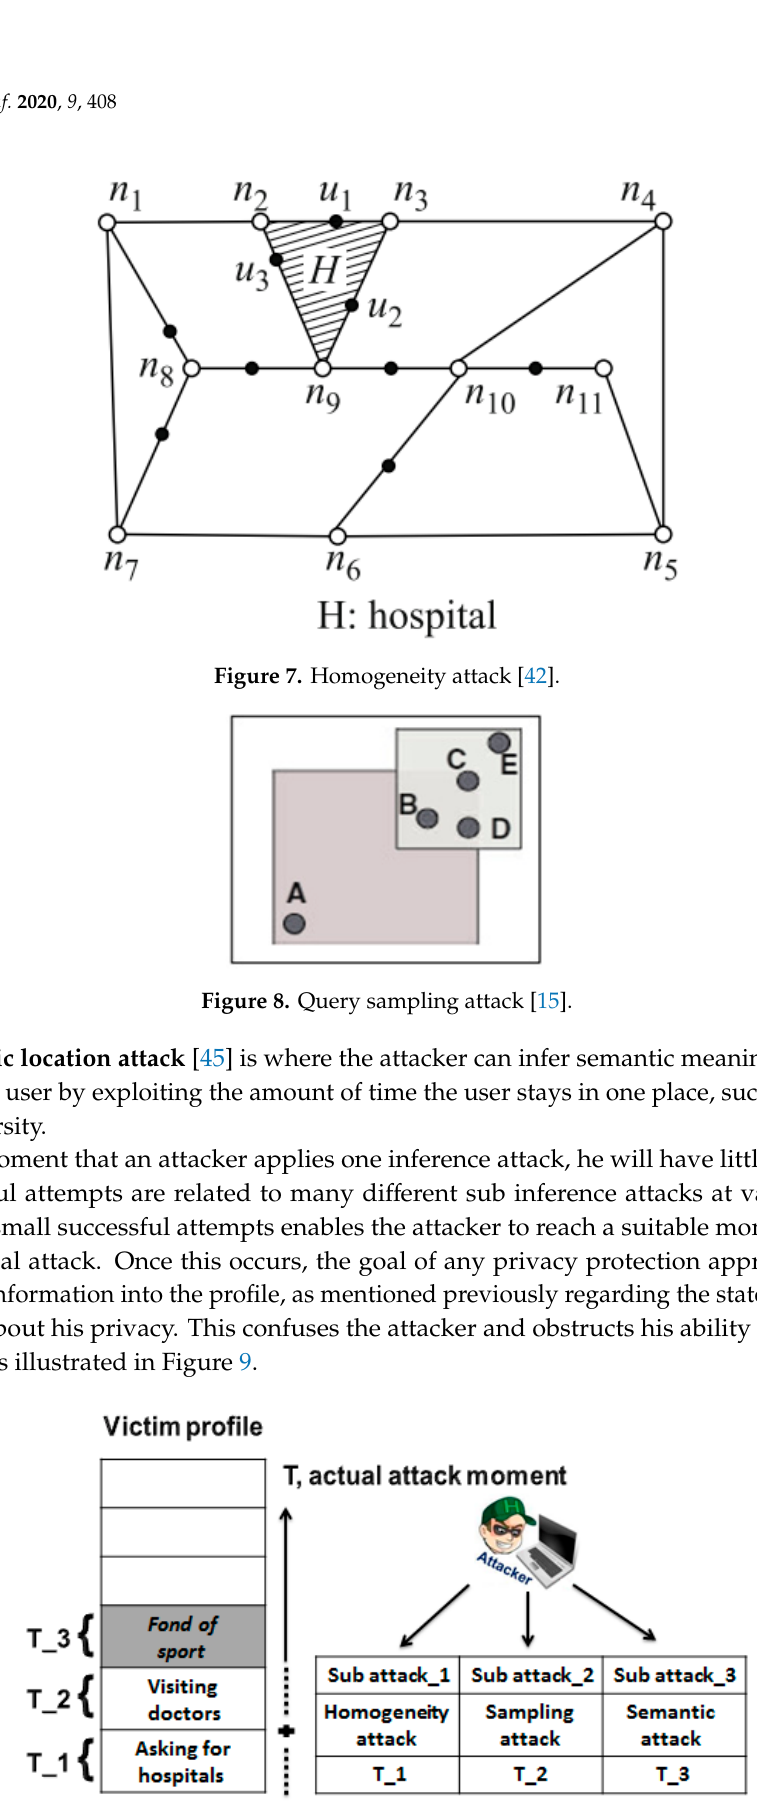
Figure 9. The profile of the LBS user specialized on the attacker side.